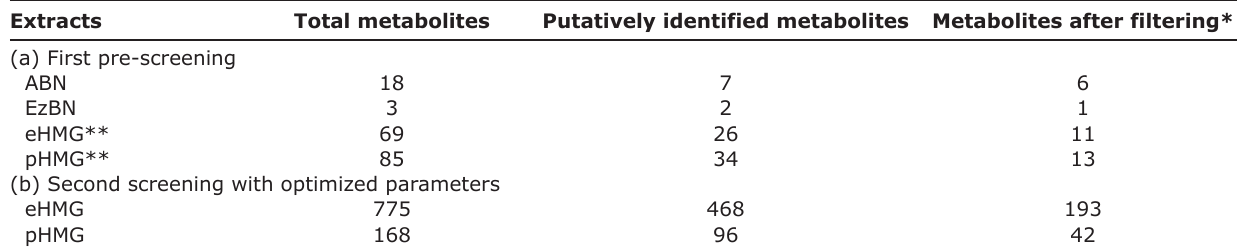
*Metabolites filtering is based on the presence of contaminants, the score and database matching error (ppm). **The extracts were selected for the second screening with the optimized LC-MS parameters. LC-MS=Liquid chromatography- mass spectrometry, QTOF=Quadrupole